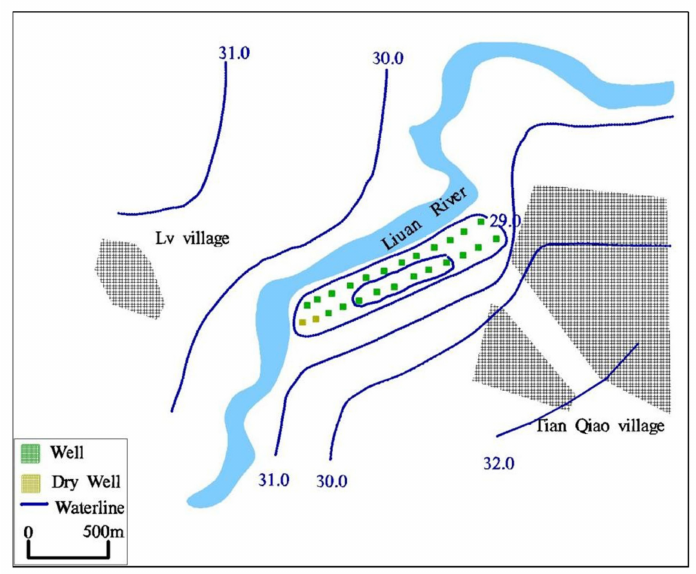
Figure 8. Water level flow field 10 days after pumping.